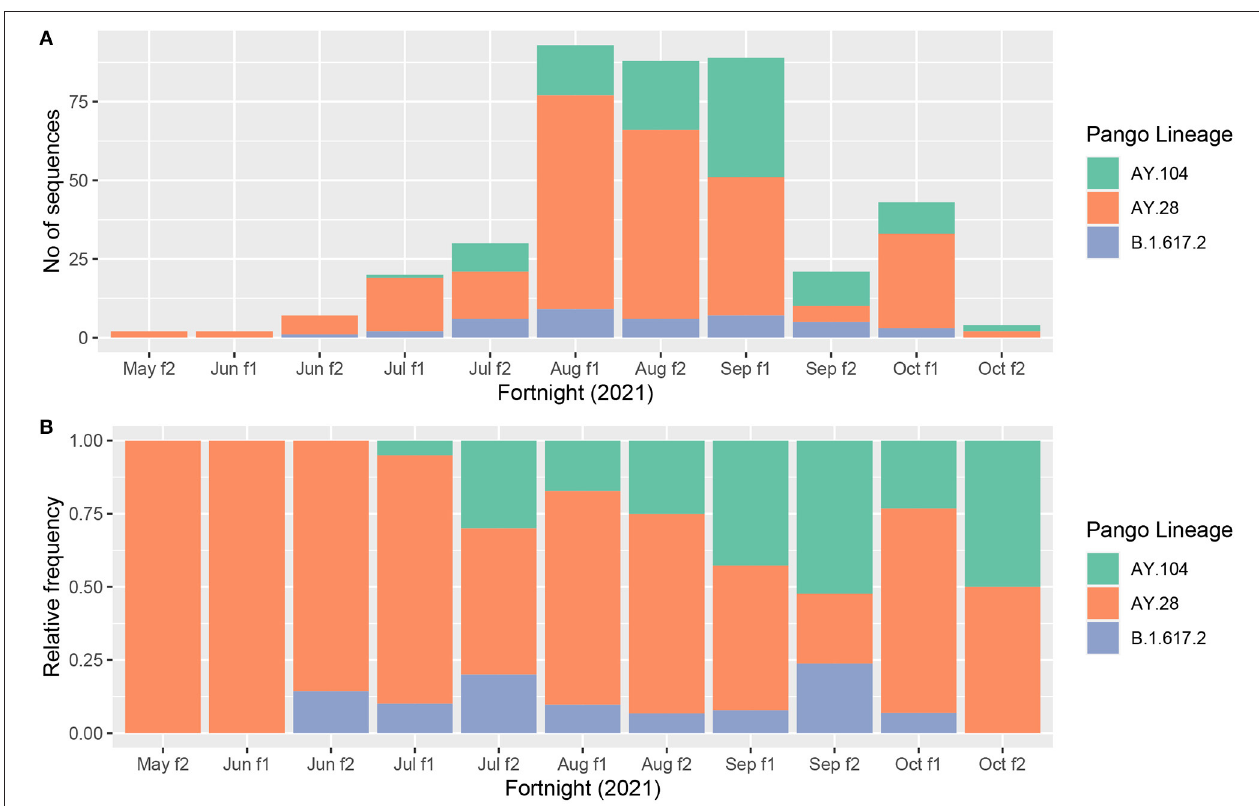
FIGURE 2 | Prevalence of AY.28 and AY.104 against the original Delta (B.1.617.2) in Colombo district. (A) Absolute prevalence of main delta sub-lineages (AY.28, AY.104 and B.1.617.2) sequenced in Colombo district ( N = 440) since mid-May to November 2021 is shown for each fortnight, month and week. (B) Relative prevalence of AY.28, AY.104 and parental B.1.617.2 sequenced in Colombo district ( N = 440) since mid-May to November